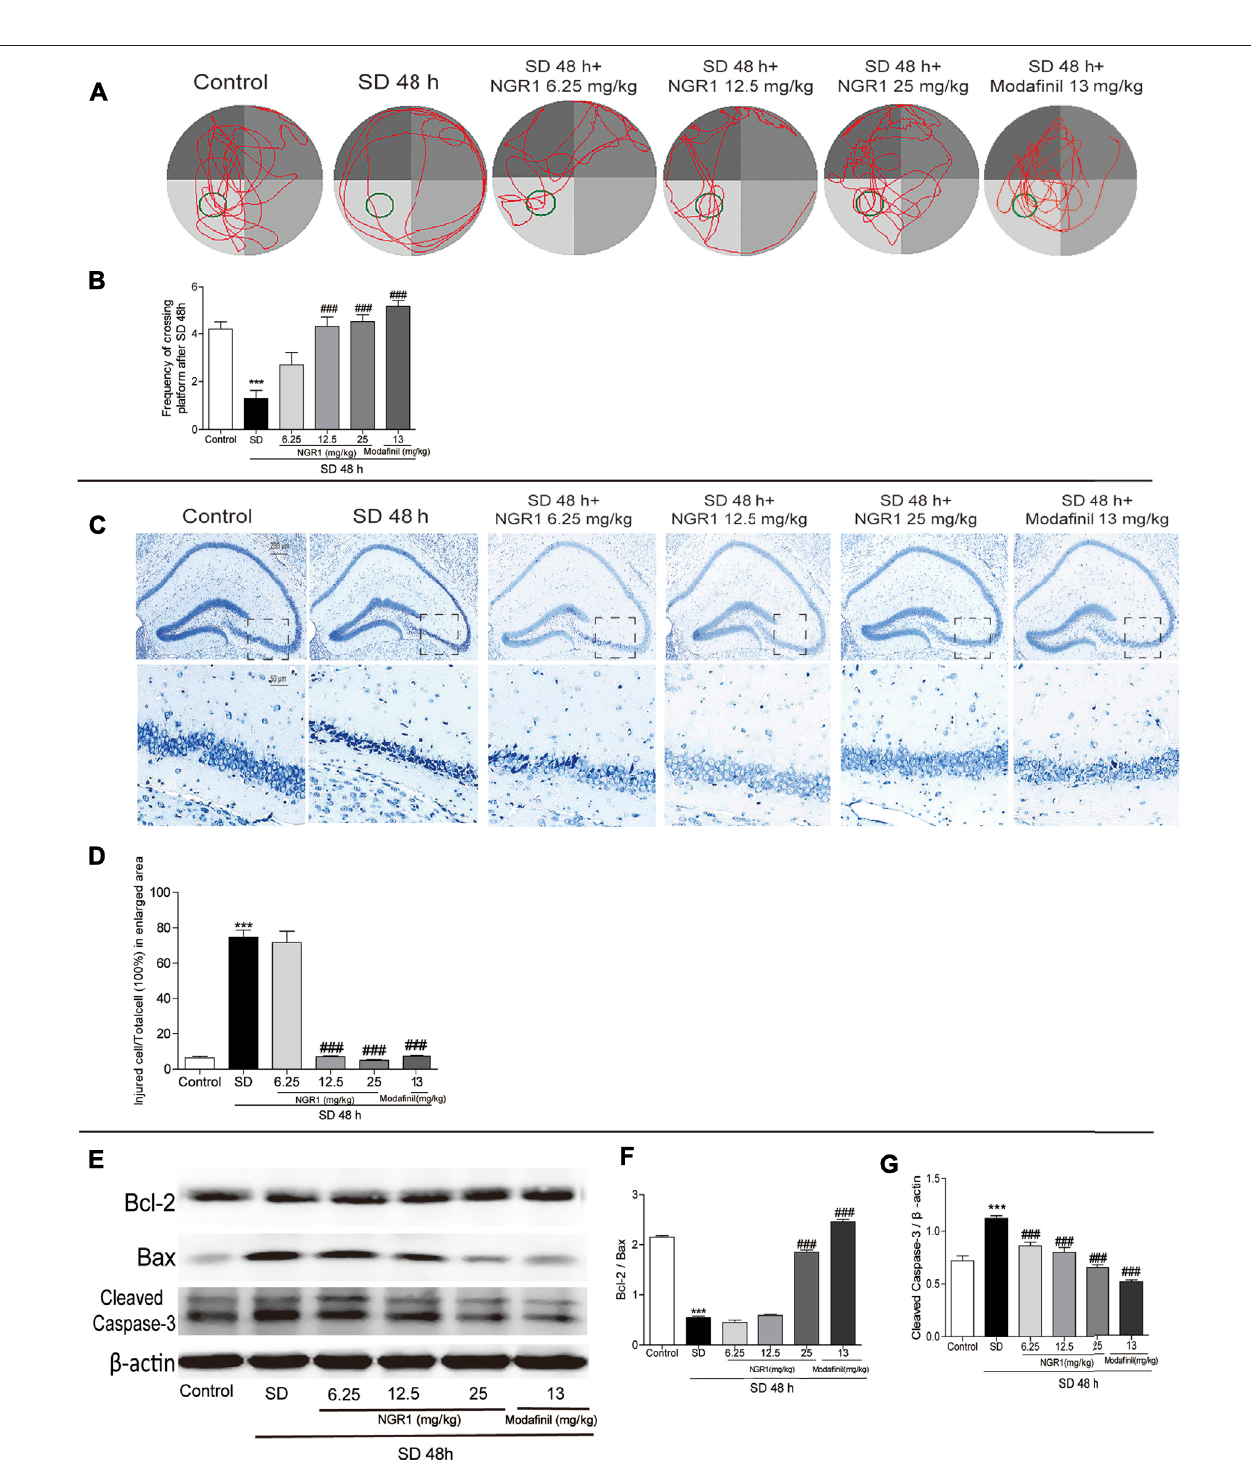
FIGURE1| NGR1counteractedtheimpairmentoflearningandmemoryofSDmice. (A) MovementtracksofmiceintheMorriswatermaze. (B) Comparisonofthe frequency ofmice passing through thetargetquadrant. (C) Nissl stainingof hippocampal regions. The enlarged images displayed hippocampal CA3 regions. Scale bar: 200 and 50 µm (D) Comparison of the percentage of injured cells in CA3 regions. n (cid:1) 3/group. (E) Hippocampal expressions of proteins involved in apoptosis. (F – G) Gray intensitycomparison ofBcl-2/Baxand cleaved caspase-3. n (cid:1) 5/group.*** p < 0.001 vs. controlgroup. ### p < 0.001 vs. SDgroup. (NGR1: notoginsenoside R1; SD: sleep